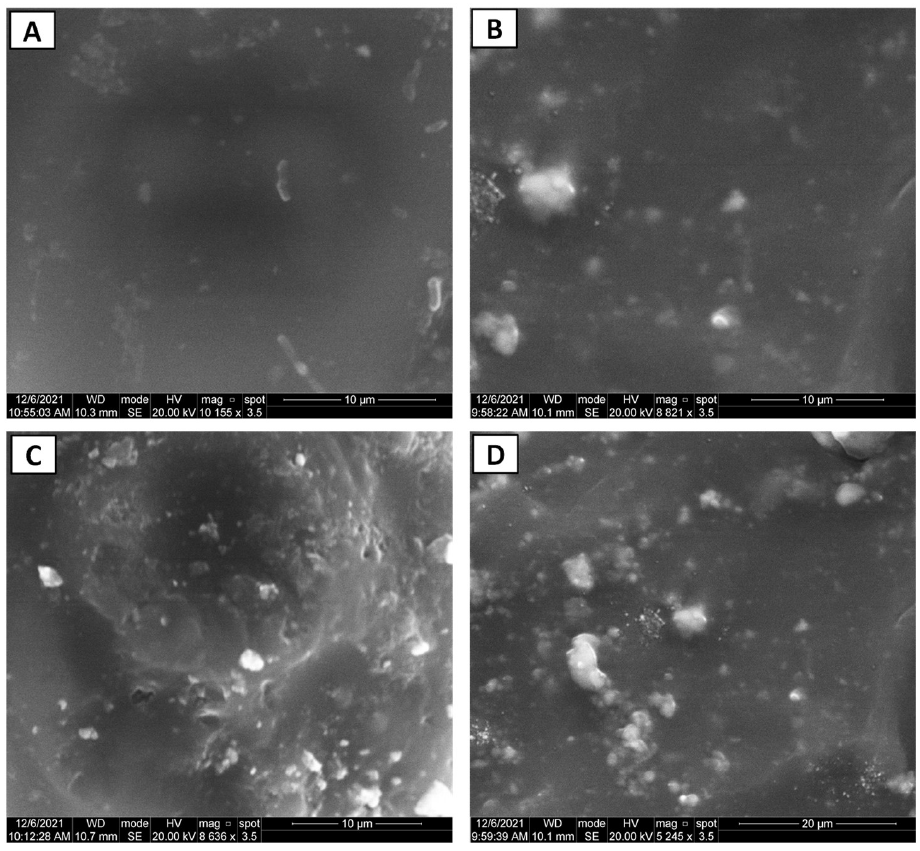
Figure 6. SEM images of ( A ) PEMA and PEMA-TiO 2 nanocomposite: ( B ) 1.0 wt.% ( C ) 1.5%, and ( D ) 2.0 wt.%.